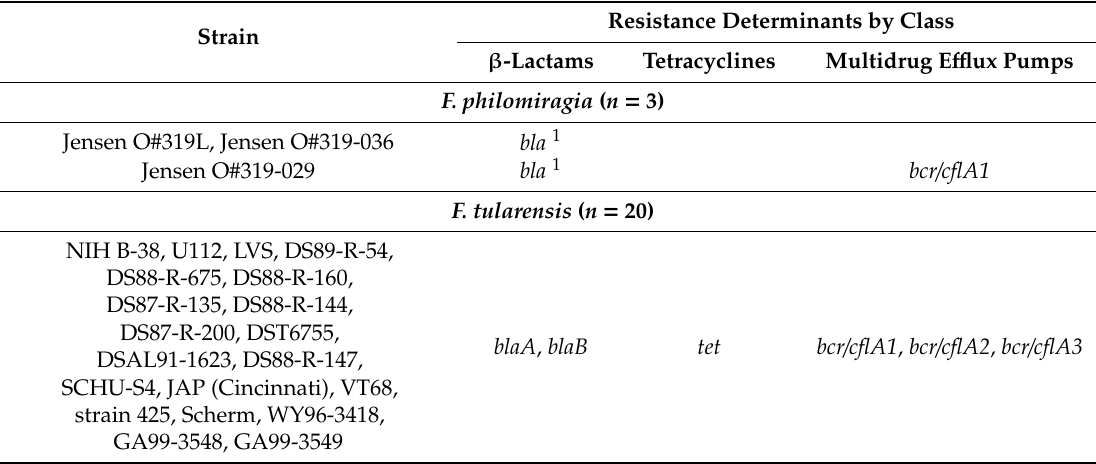
Table 2. Microarray-detected antimicrobial resistance (AMR) genes in Francisella spp.